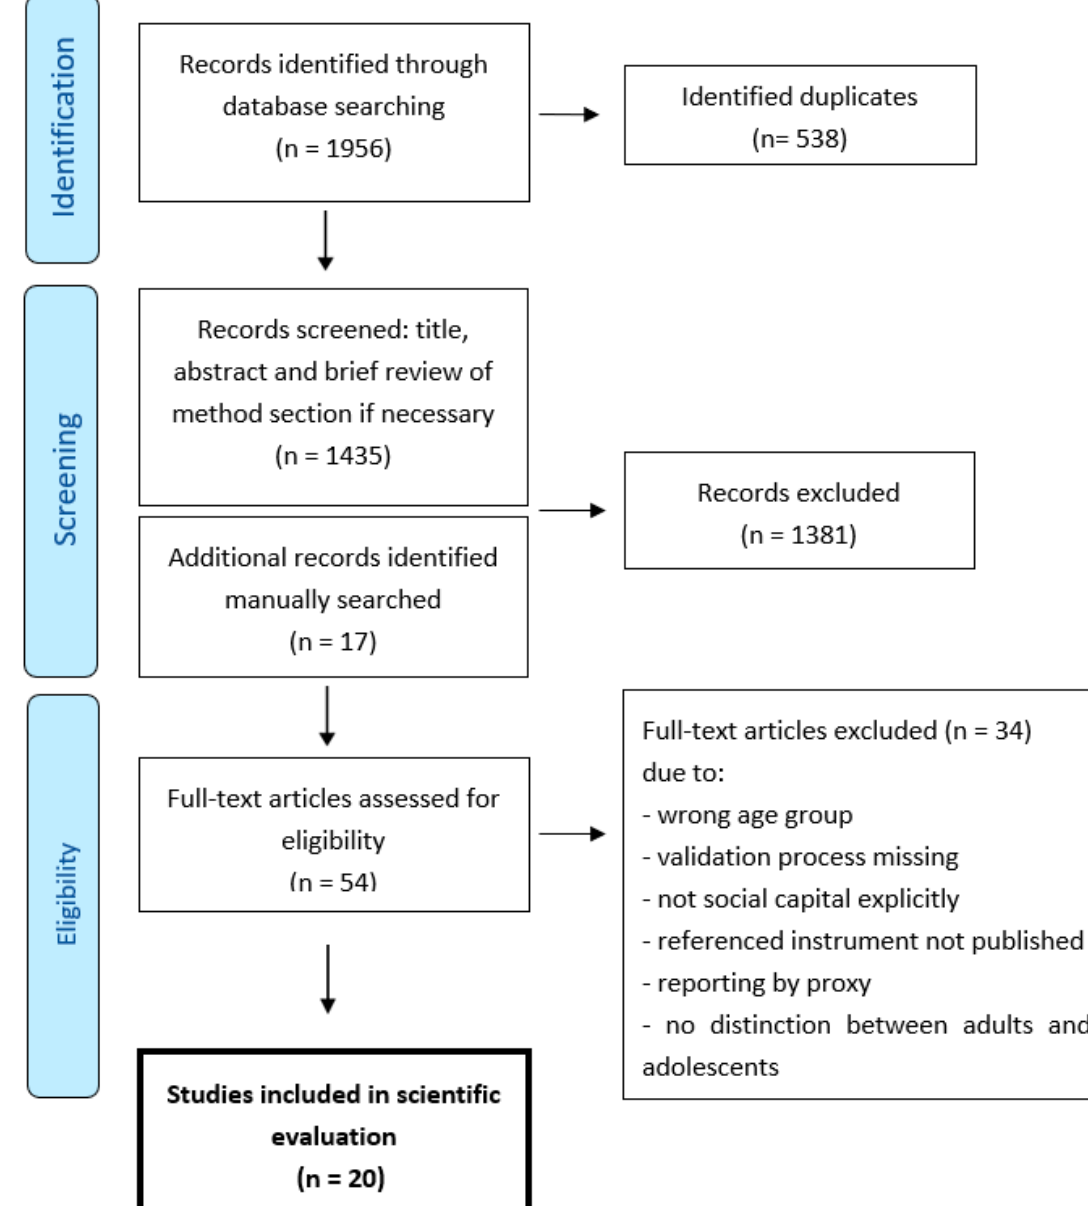
Figure 1. Flowchart diagram of study selection process.